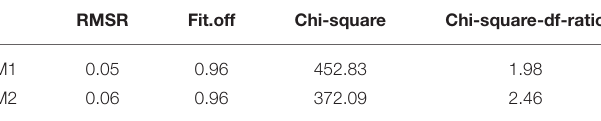
TABLE 3 | Model fit of ESEM. TABLE 4 | Bivariate correlations of both TPA scales and symptom severities.